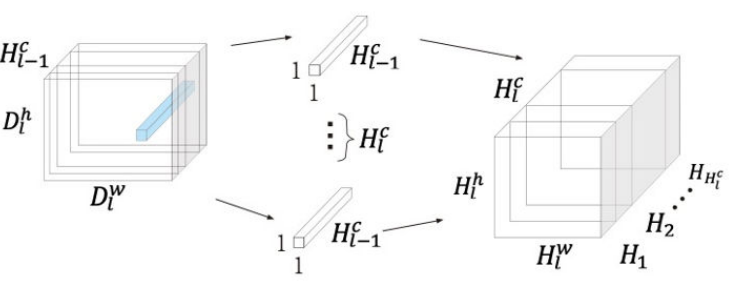
Figure 3. The second step of depthwise separable convolution: learning cross-channel information using H c different kernels Z l l